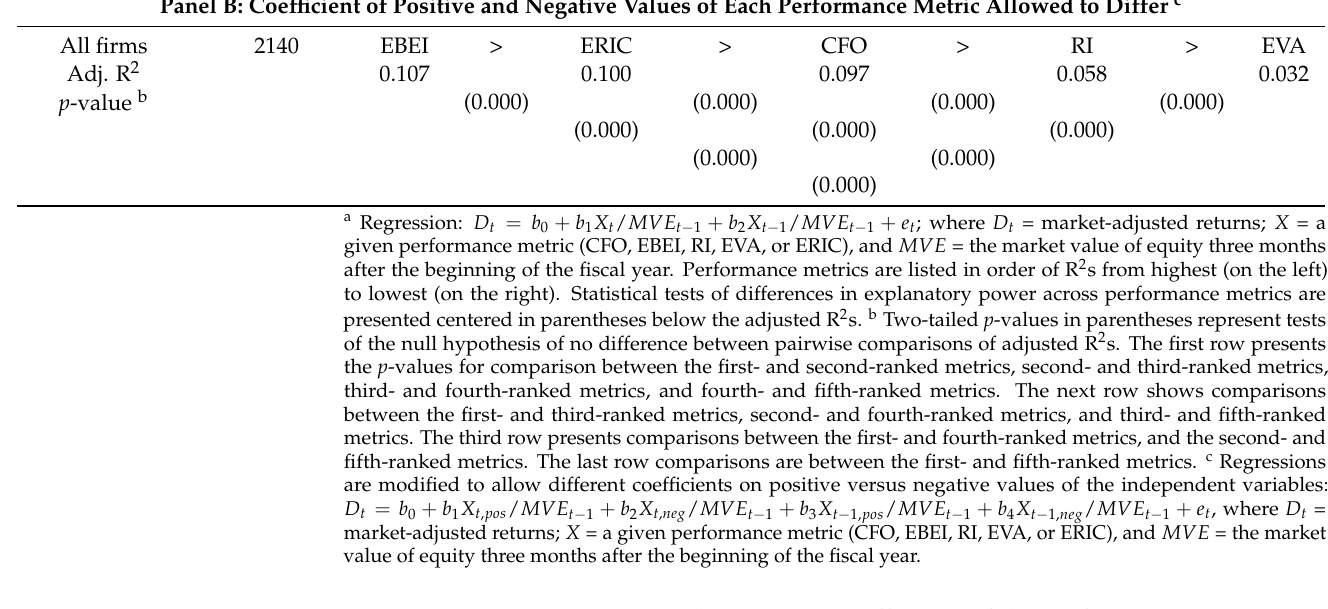
Panel B: Coefficient of Positive and Negative Values of Each Performance Metric Allowed to Differ